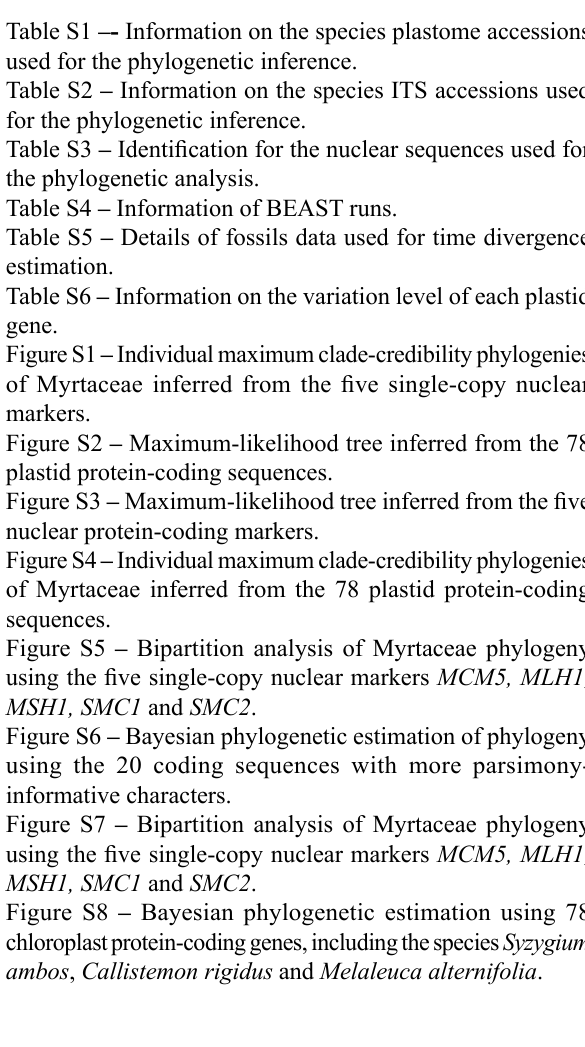
Figure S1 – Individual maximum clade-credibility phylogenies of Myrtaceae inferred from the five single-copy nuclear markers. Figure S2 – Maximum-likelihood tree inferred from the 78 plastid protein-coding sequences. Figure S3 – Maximum-likelihood tree inferred from the five nuclear protein-coding markers. Figure S4 – Individual maximum clade-credibility phylogenies of Myrtaceae inferred from the 78 plastid protein-coding sequences. Figure S5 – Bipartition analysis of Myrtaceae phylogeny using the five single-copy nuclear markers MCM5, MLH1, MSH1, SMC1 and SMC2 . Figure S6 – Bayesian phylogenetic estimation of phylogeny using the 20 coding sequences with more parsimony- informative characters. Figure S7 – Bipartition analysis of Myrtaceae phylogeny using the five single-copy nuclear markers MCM5, MLH1, MSH1, SMC1 and SMC2 . Figure S8 – Bayesian phylogenetic estimation using